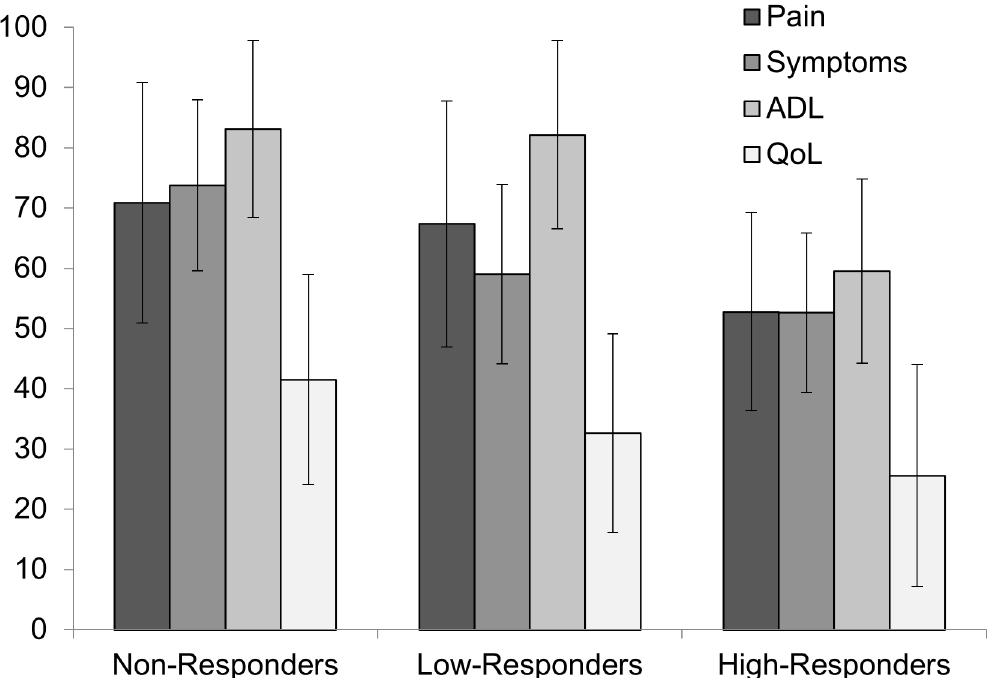
Fig 5. Pre-intervention Knee Injury and Osteoarthritis Outcome Score subscales of pain, symptoms, function in daily living (ADL), and knee related quality of life (QoL) of Non-Responders, Low-Responders, and High-Responders. Note: KOOS is measured on a scale of 100, with 100 best (e.g., no pain) and 0 being worst (e.g., most pain